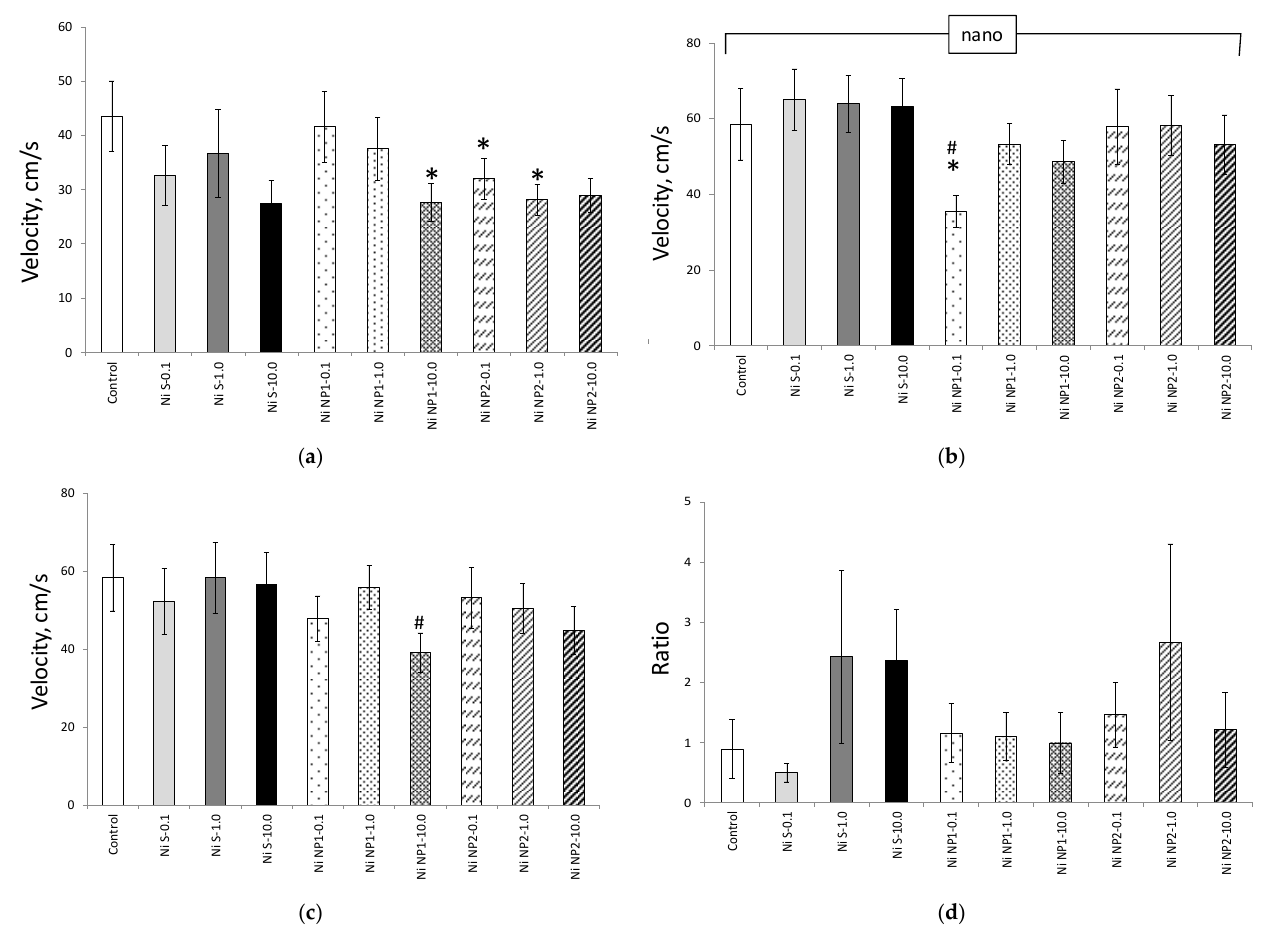
Figure 7. Indicators (M ± S.E.M) of locomotor activity ( a – c ) and anxiety ( d ) of rats in the EPM test during the experiment: ( a ) maximum speed in OA, cm/s; ( b ) maximum speed in CA, cm/s; ( c ) maximum speed in general, cm/s; ( d ) the ratio of the residence times in the CA and OA, dimensionless. *—the difference with group 1 (control) is significant; #—the difference with the group receiving the salt form of Ni (Ni S) in an equivalent dose, is significant, Mann–Whitney U -test. Horizontal bracket–non-uniform distribution by factors of the presence of nanoform (nano), p < 0.05, ANOVA test. The number of animals is 12 in each group.